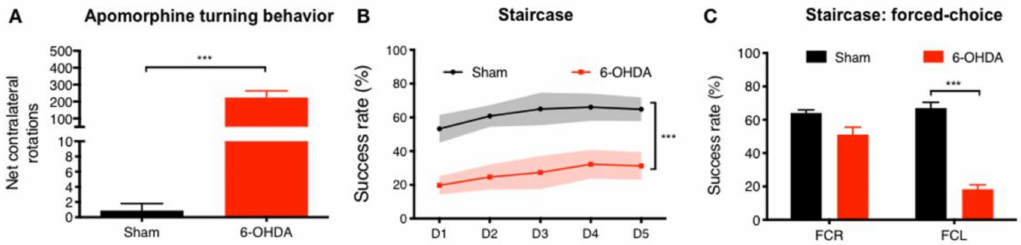
Figure 2. 6-OHDA PD model phenotypic validation. Using the apomorphine turning behavioral test, it was verified that after 3 weeks of 6-OHDA injections, there was ( A ) an intense turning behavior promoted by the injection of apomorphine when compared to Sham group, demonstrating that animals’ dopaminergic integrity was a ff ected. Additionally, through the staircase test, it was verified that after 6-OHDA administration there was a ( B , C ) significant reduction on fine motor coordination of the tested animals. For apomorphine turning behavioral test Sham n = 9, 6-OHDA n = 18. For staircase Sham n = 9, 6-OHDA n = 18. Data presented as mean ± S.E.M. *** p < 0.001. FCR—forced choice task at right side; FCL—forced choice task at left